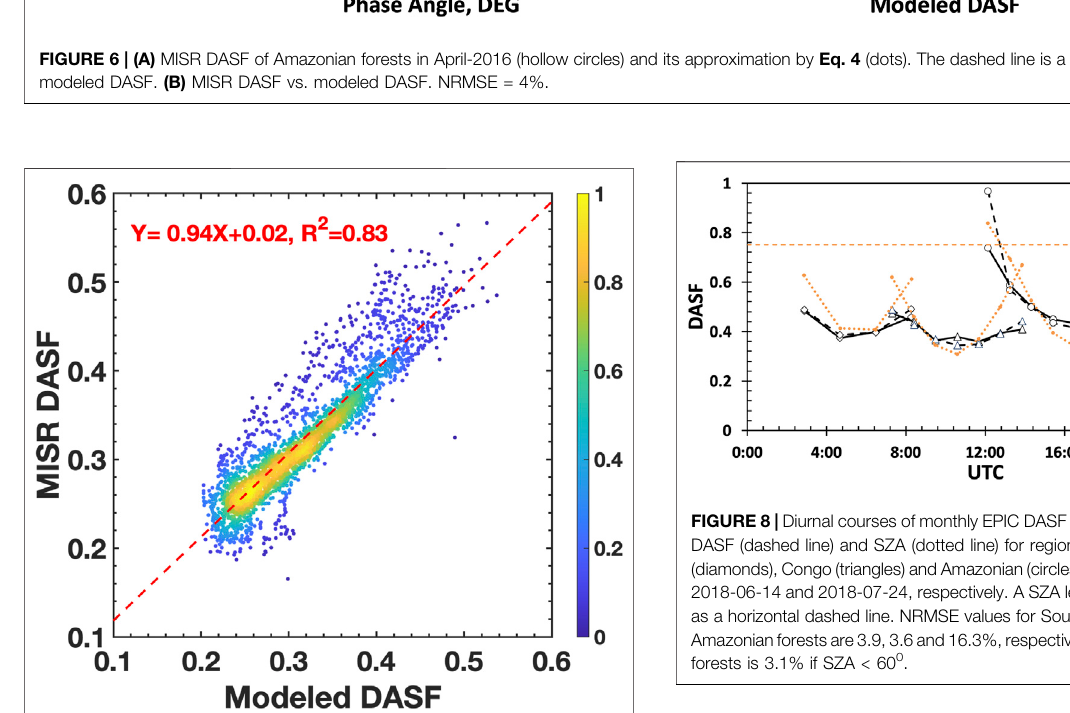
FIGURE 7 | MISR DASF vs . its approximation by Eq. 4 accumulated over our study area during Year 2016. NRMSE (cid:2) 9.2%; R 2 (cid:2) 0.83.